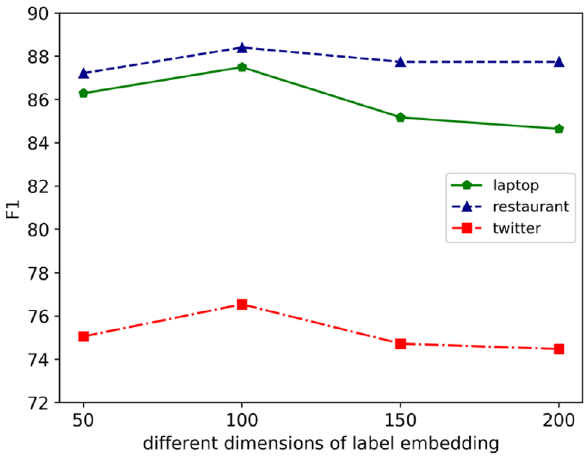
Fig. 13 F1ofIANNtowarddifferentnumbersoflayersonthreedatasets twitter dataset, the restaurant dataset, and the laptop dataset. The corresponding results are shown in Fig. 13.